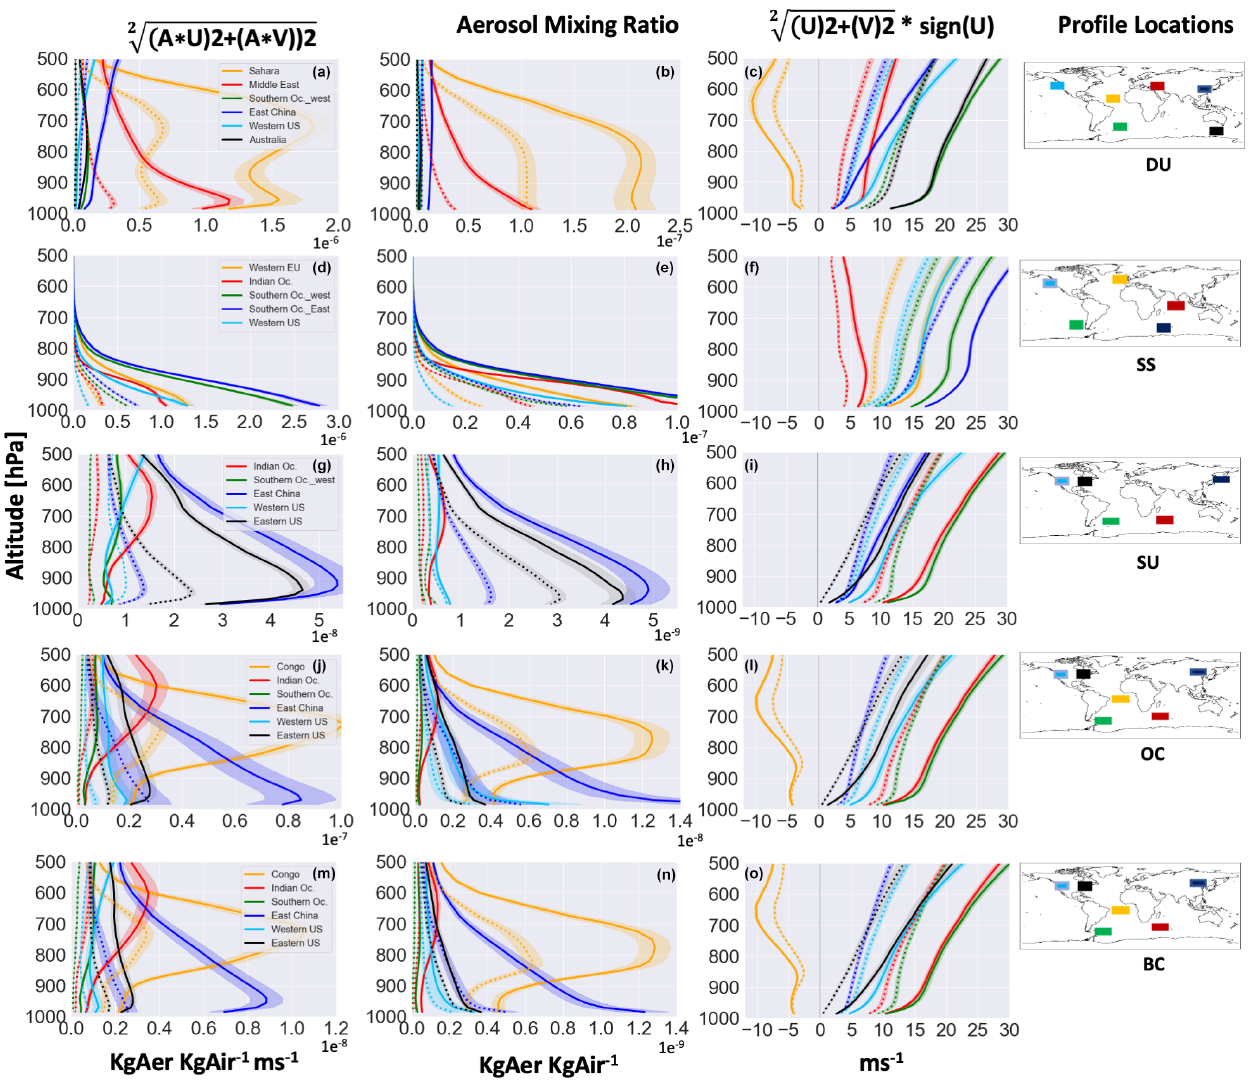
Figure 5. Average vertical profiles of (a, d, g, j, m) aerosol mass fluxes, (b, e, h, k, n) aerosol mixing ratios, and (c, f, i, l, o) wind speed over a number of locations for AAR events (solid) and all (dotted) time steps. Please see the AAR frequency maps in the inset of the middle panel for the locations chosen to calculate the profiles. In panels (c, f, i, l, o) , a sign convention (see the column title) is used to highlight the general east–west direction of the wind speed